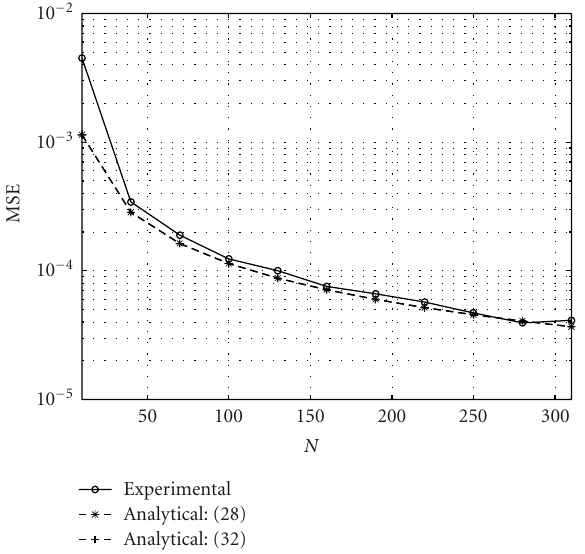
Figure 4: The MSE of the estimated channel versus SNR. The BP